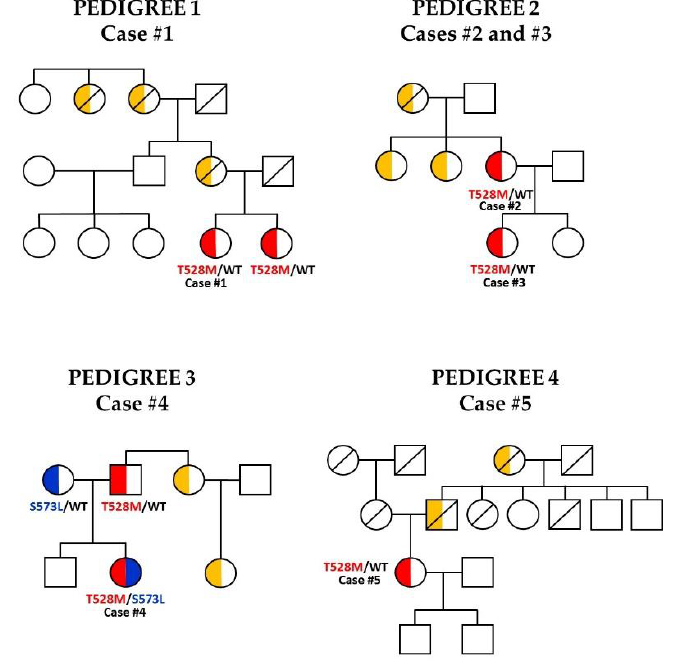
Figure 2. Pedigrees of the four families with FPLD2 due to the p.(Thr528Met) variant. Genograms. Affected individuals with the LMNA p.(Thr528Met) variant and the LMNA p.(Ser573Leu) variant are shown as half-filled red and blue symbols, respectively, unaffected subjects as unfilled symbols, individuals for whom the phenotype is suspected are shown as half-filled orange symbols. Squares denote males, and circles denote females. Circles and squares with a diagonal slash denote deceased subjects. The inheritance pattern was autosomal dominant in a vertical way.